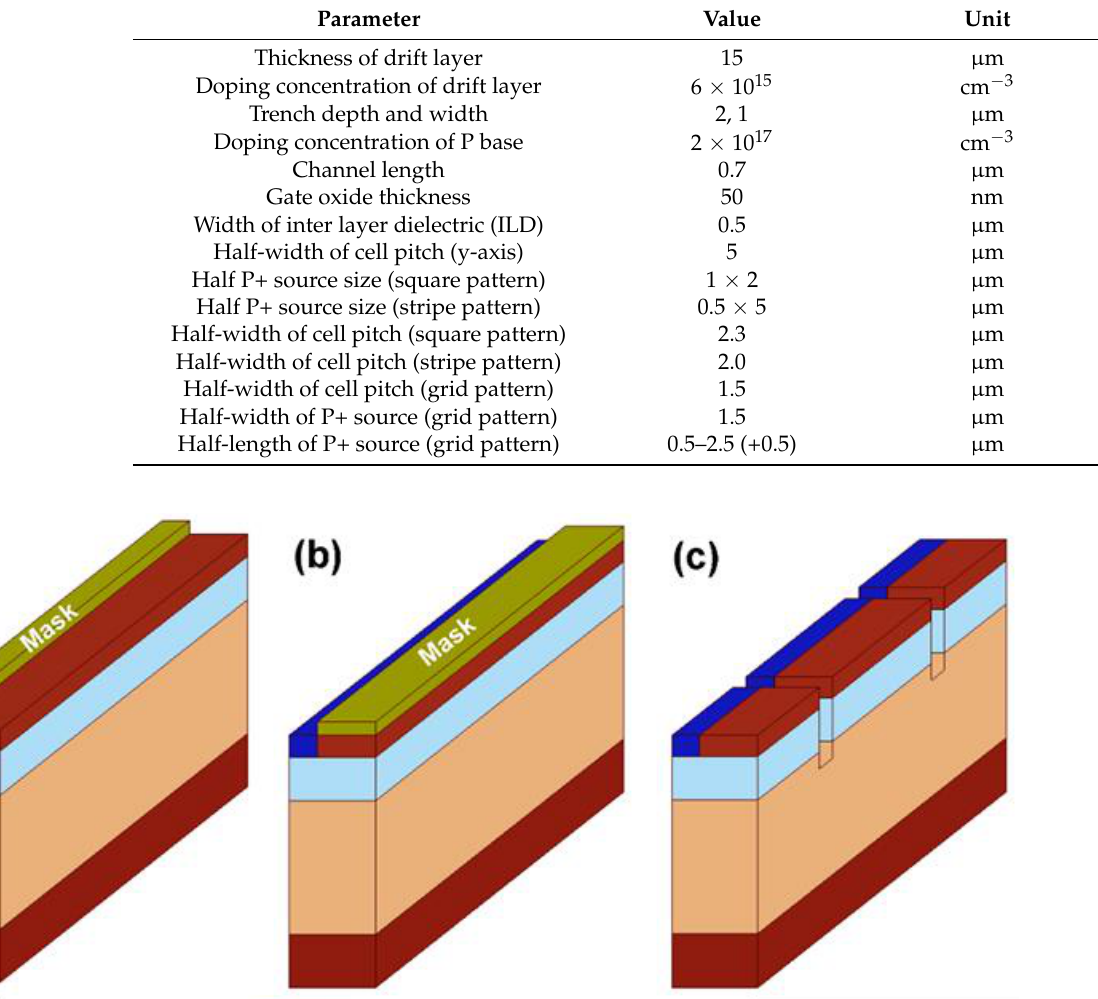
Table 1. Device structural parameters.